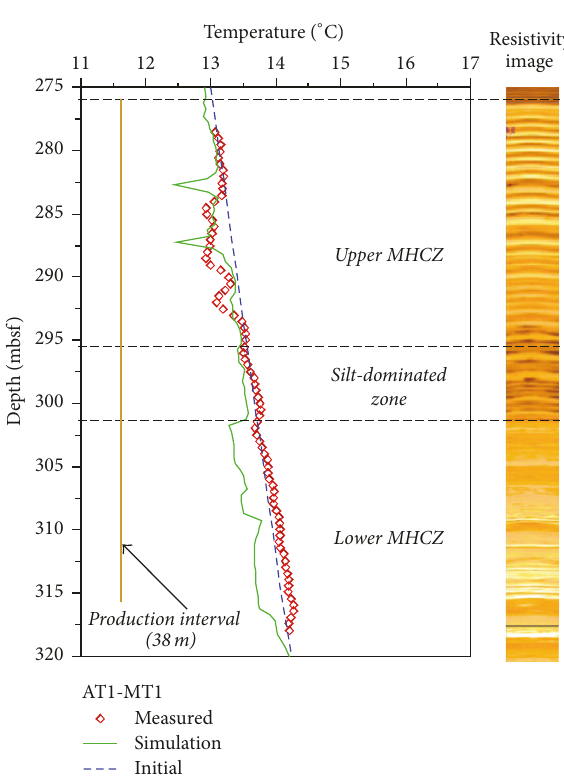
Figure 11: Measured and simulated temperature changes at the location of monitoring well AT1-MT1on day 5 with resistivity image. Initial temperature profile is also shown in the figure with dashed blue line. The offset of the monitoring well AT1-MT1 from the production well AT1-P is 22 m at the reservoir depth as shown in Figure